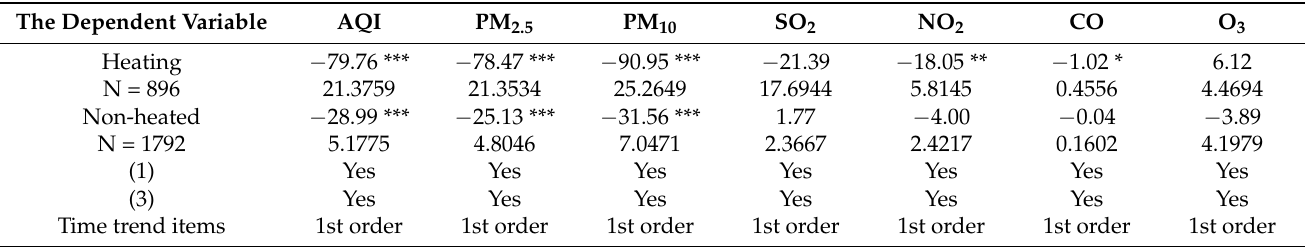
Table 7. Results of RD estimation of daily frequency in heating versus non-heating